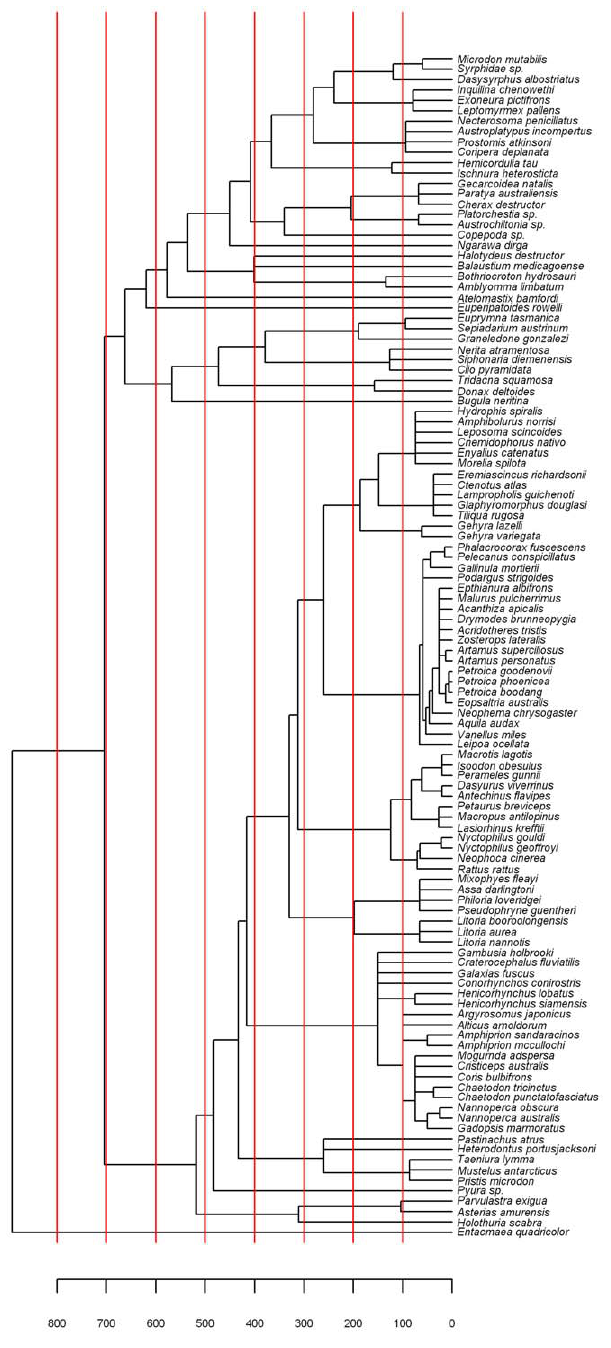
Figure 2. Phylogenetic tree of the plant species studied. The cutoff limits used for autocorrelation analyses of microsatellite coverage are indicated in red.